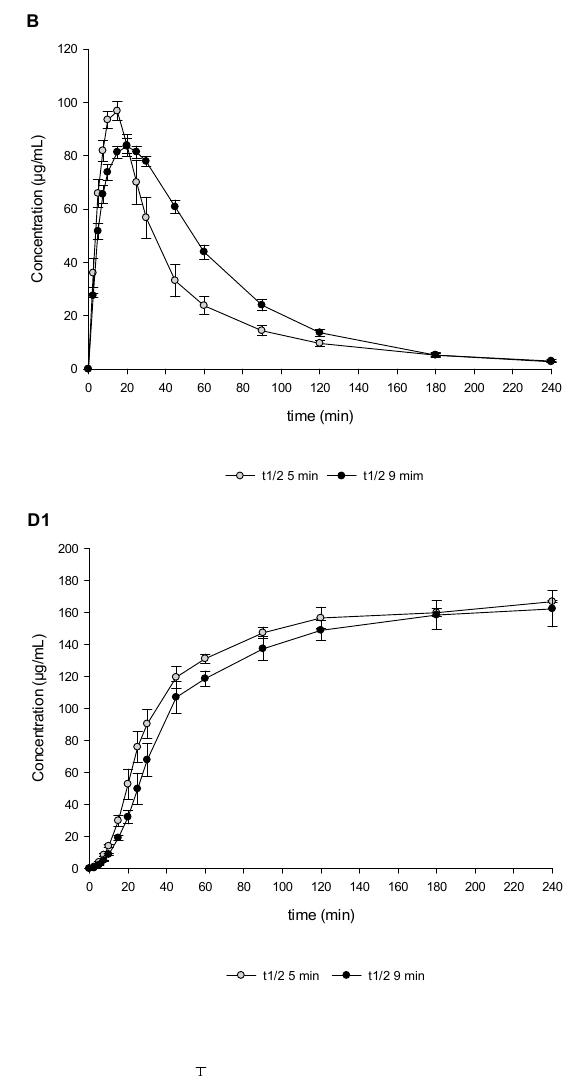
Figure 3. Drug concentration profiles (dissolved, ( A )), total amount profiles (dissolved and undis- solved/precipitate, ( B )), and undissolved/precipitated amount ( C ) obtained from the aqueous fil- tered and un-filtered phase; partitioning profiles (( D1 ) concentration/time vs. ( D2 ) mass/time) ob- tained from the organic phase during in vitro DTPS experiments using VR of 0.4 vs. 0.8 and 75 mg IR tablet formulation. The precipitated mass/amount (Equations (1) and (4)) must be considered as solid mass/amount consisting of undissolved and precipitated API. Means ± SD, n = 3.